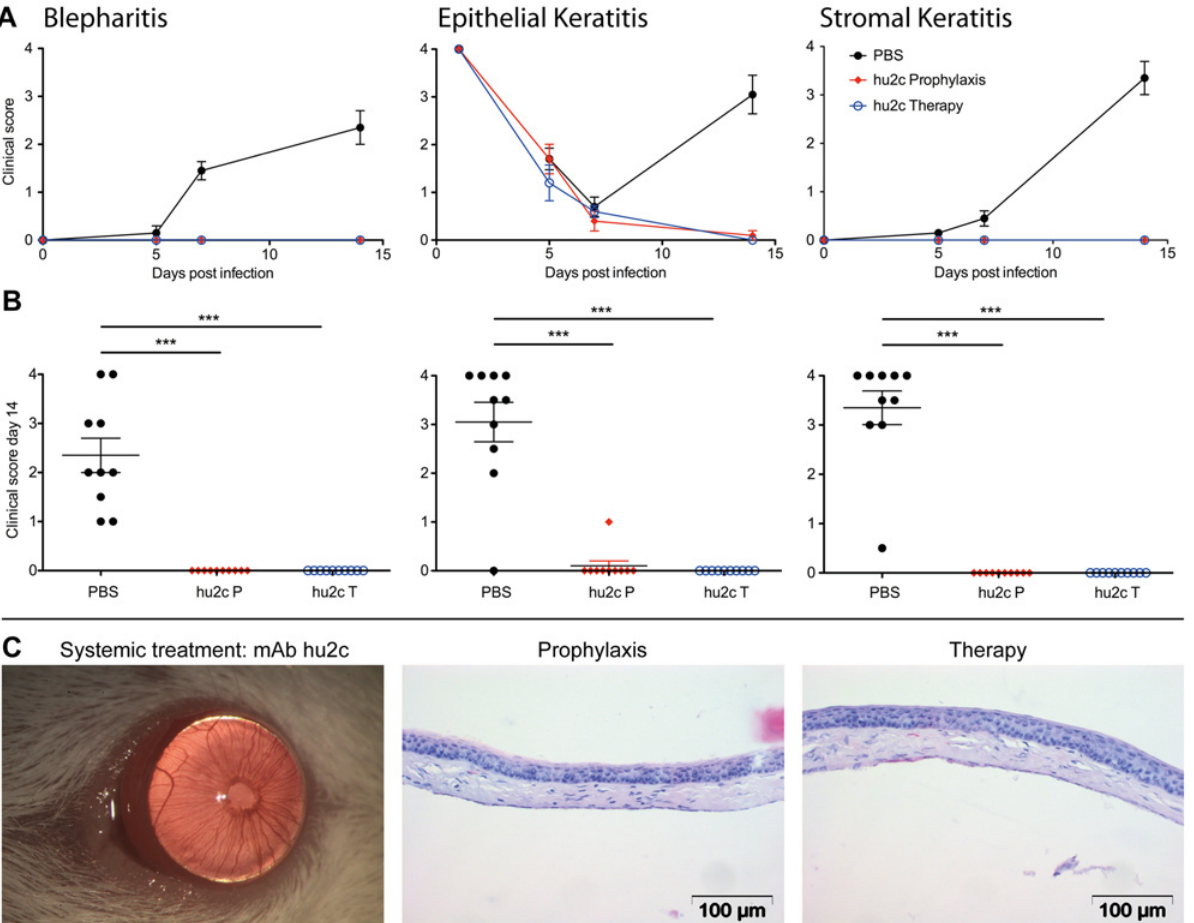
Figure 11. Prevention of corneal HSV-1 KOS infection in mice by the humanized antibody mAb hu2c. The clinical disease scores of infected mice for blepharitis, epithelial defects and corneal opacity (stromal keratitis) are shown as an average score of ten mice per group over a period of 14 days (A) or as dot plot (B) taken on day 14 after infection. Every dot represents a single mouse. Differences between the groups were statistically significant by a nonparametric ANOVA one way test ( ** P < 0.01; *** P < 0.001). Error bars represent the SEM. PBS-treated group showed in Fig. 3 serves as control. Pictures and histological stainings representative for mice systemically treated with mAb hu2c are shown (C) . Haematoxylin-eosin staining. Magnification: 120x. Scale bars:100 μ m.